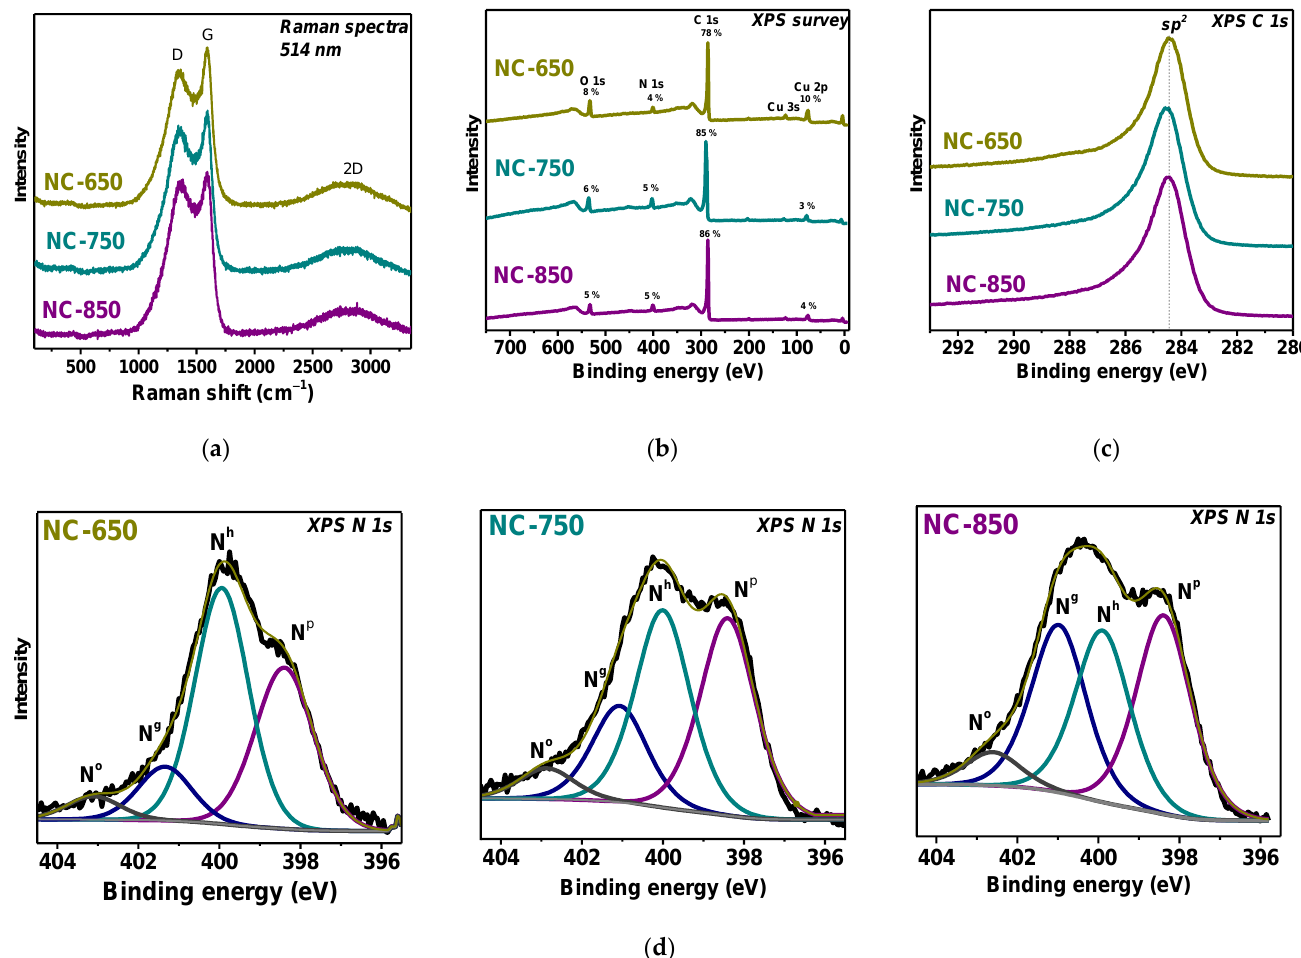
Figure 4. ( a ) Raman scattering and XPS ( b ) survey, ( c ) C 1s, and ( d ) N 1s spectra of NC-650, NC-750, and NC-850.